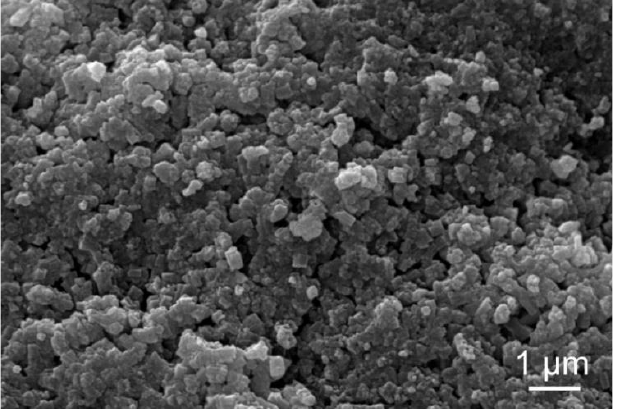
Figure 7. Homogeneous granular structure in Sphenothallus sp. from the Upper Ordovician of Estonia.